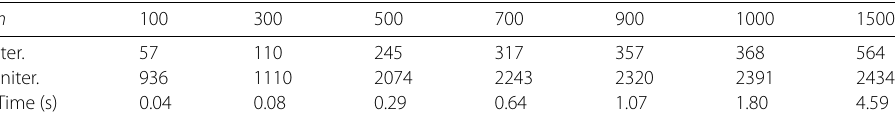
Table 1 Iteration number and CPU computing time of Algorithm 1 with different dimensions n 100 300 500 700 900 1000 1500